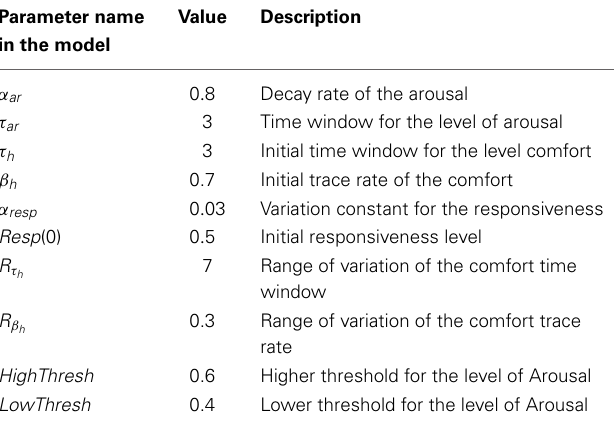
Table 2 | Parameters used in the adaptive regulation